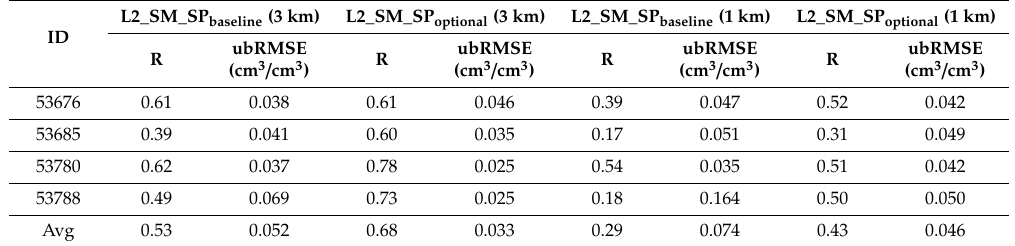
Table 4. Results comparison summary of the L2_SM_SP products (3 km and 1 km) vs. in situ SM. The number of samples at stations 53676, 53685, 53780, and 53788 was 36, 37, 34, and 33, respectively. Avg is short for average.